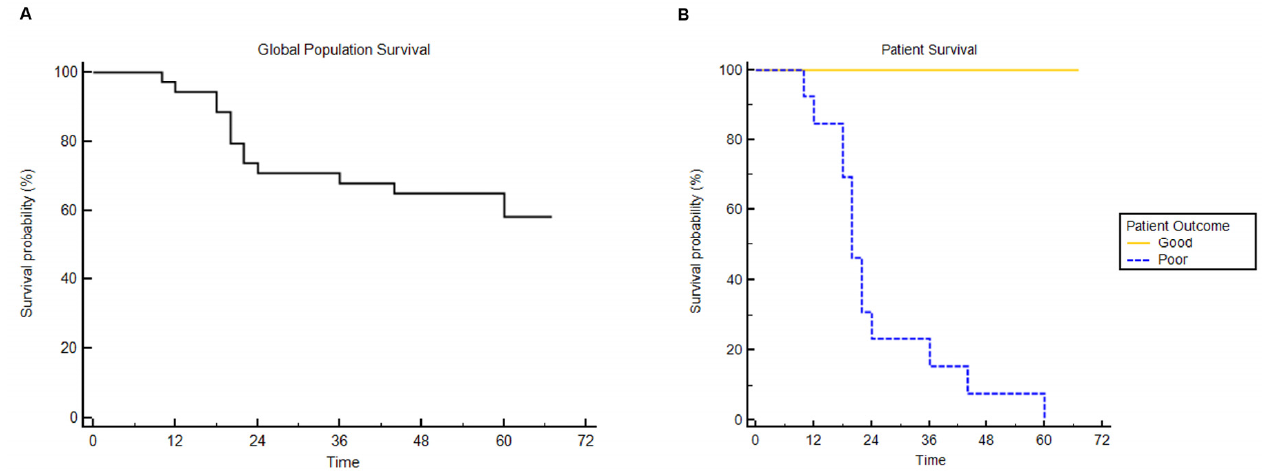
Figure 2. Overall survival analysis. Overall survival curve for all 35 patients evaluated ( A ); ( B ) overall survival for 15 patients defined as long and short survival and with the same characteristic for ECOG, comorbidity and tumor staging, histology, and